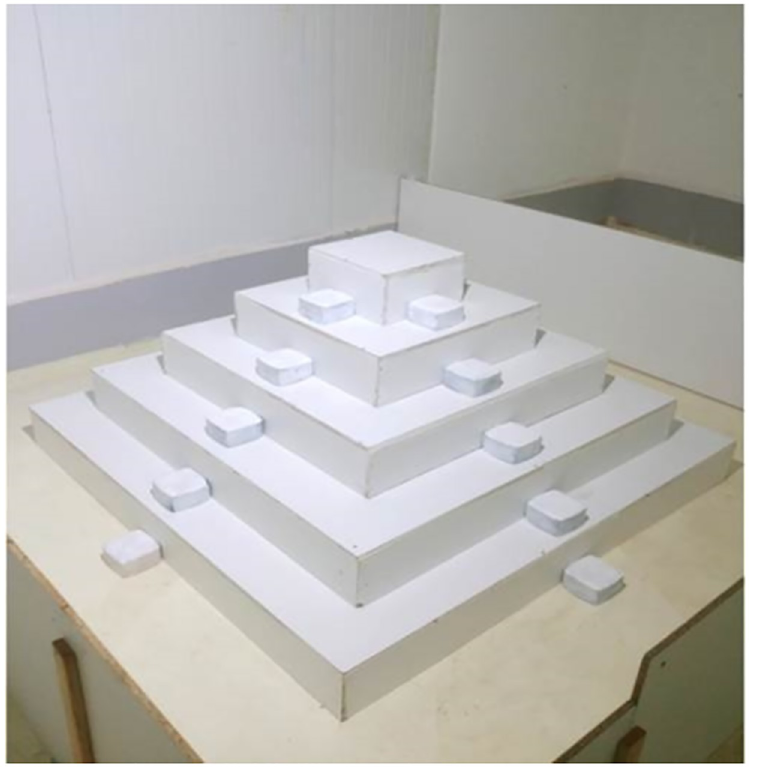
Fig 2. The ziggurat apparatus (five-level